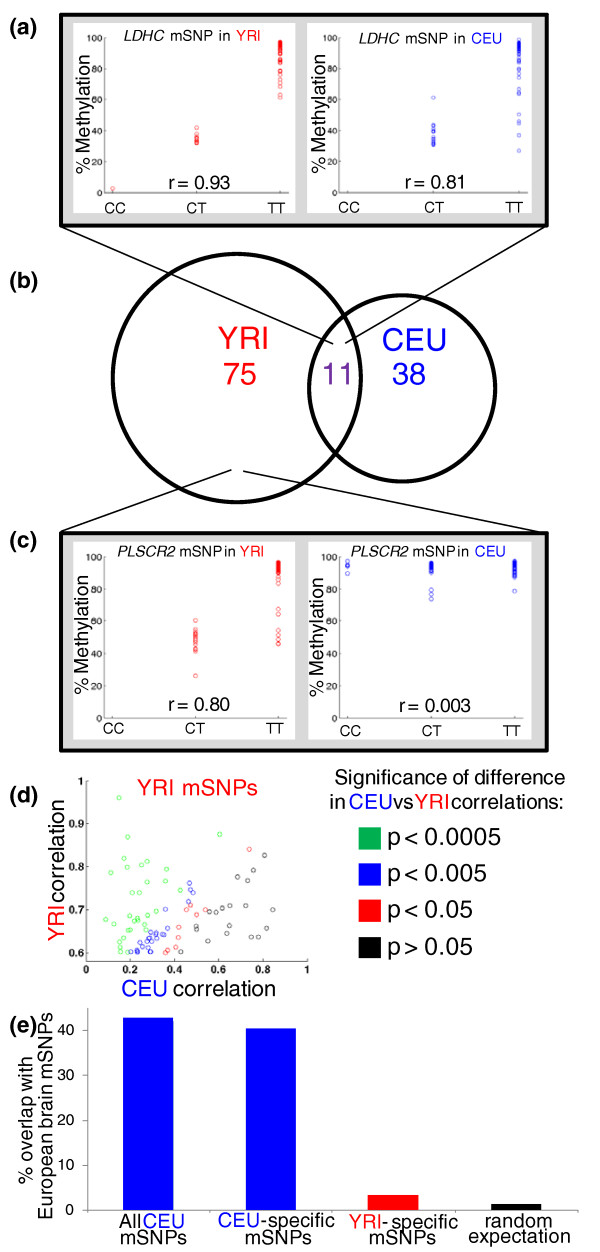
Population specificity of mSNPs. (a) An example of an mSNP (between a CpG site near LDHC (chromosome 11, base 18390591), and rs2643856) that is found in both YRI and CEU. In both cases the T allele is associated with higher methylation. (b) Venn diagram of the overlap among CpG sites associated with an mSNP in YRI and/or CEU. Five CEU sites and eight YRI sites were excluded from the overlap analysis because they overlapped a SNP in the other population. (c) Example of an mSNP (between a CpG site near PLSCR2 (chromosome 3, base 147696535) and rs12489924) that is found in YRI but not CEU. No other SNPs in CEU within 100 kb of the CpG are associated with methylation at the site (r < 0.25 for all), indicating that the difference is unlikely to be due to differing LD between rs12489924 and the causal variant. (d) Scatter plot of all 86 YRI mSNPs, showing the strongest association found for that site in each population. Points are colored according to the significance of the difference in the associations within each population; most mSNP association strengths are significantly (P < 0.005) different between populations. The same plot for CEU mSNPs is shown in Figure S10 in Additional file 1. (e) Overlap of LCL mSNPs with brain mSNPs from two studies of European populations (similar to CEU). Both all CEU mSNPs and CEU-specific mSNPs show similar overlap of 40 to 42%, which is thus a minimum estimate for the extent of mSNPs shared between LCLs and brain. However, YRI-specific mSNPs show only 3.2% overlap, not significantly different from the 1.2% expected from any random set of CpG sites.